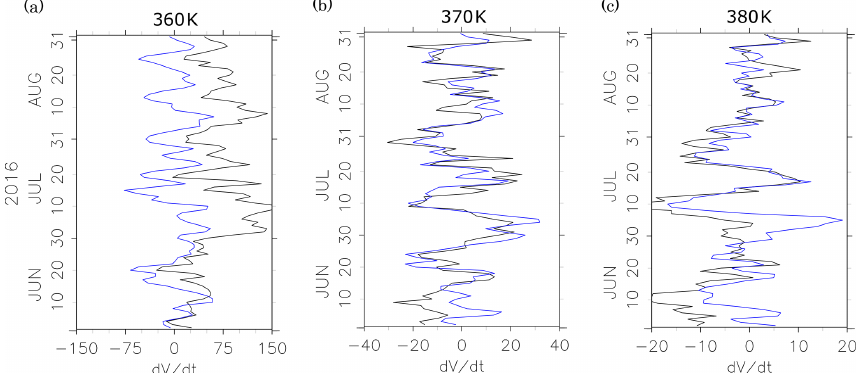
ˆ A west (blue: the left-hand side of Eq. 6) and westward zonal d t